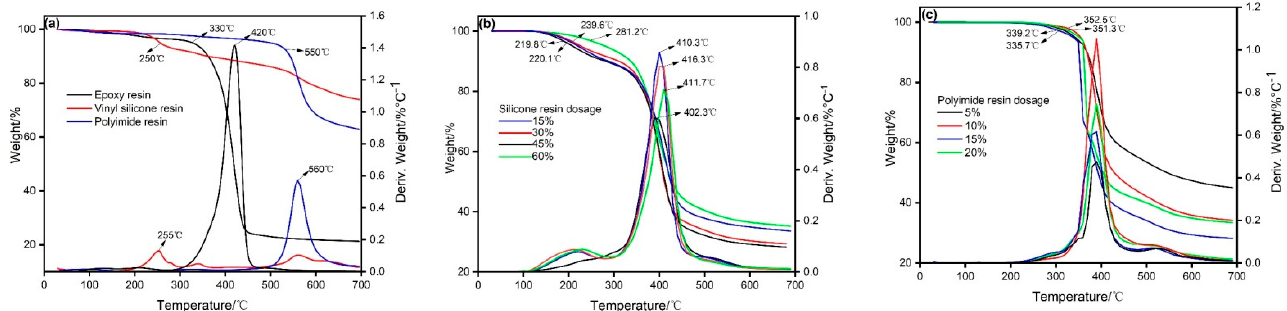
Figure 3. TGA analysis of resins: ( a ) Resin raw materials, ( b ) Modified resin raw materials, ( c ) Ternary resin.